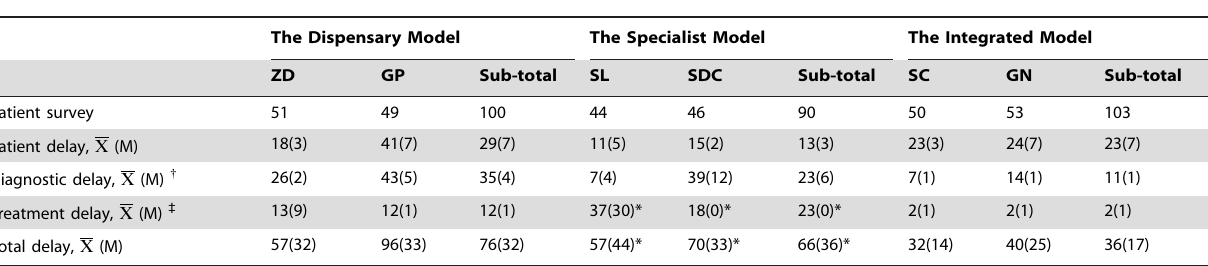
Table 6. Delays of TB patients in three